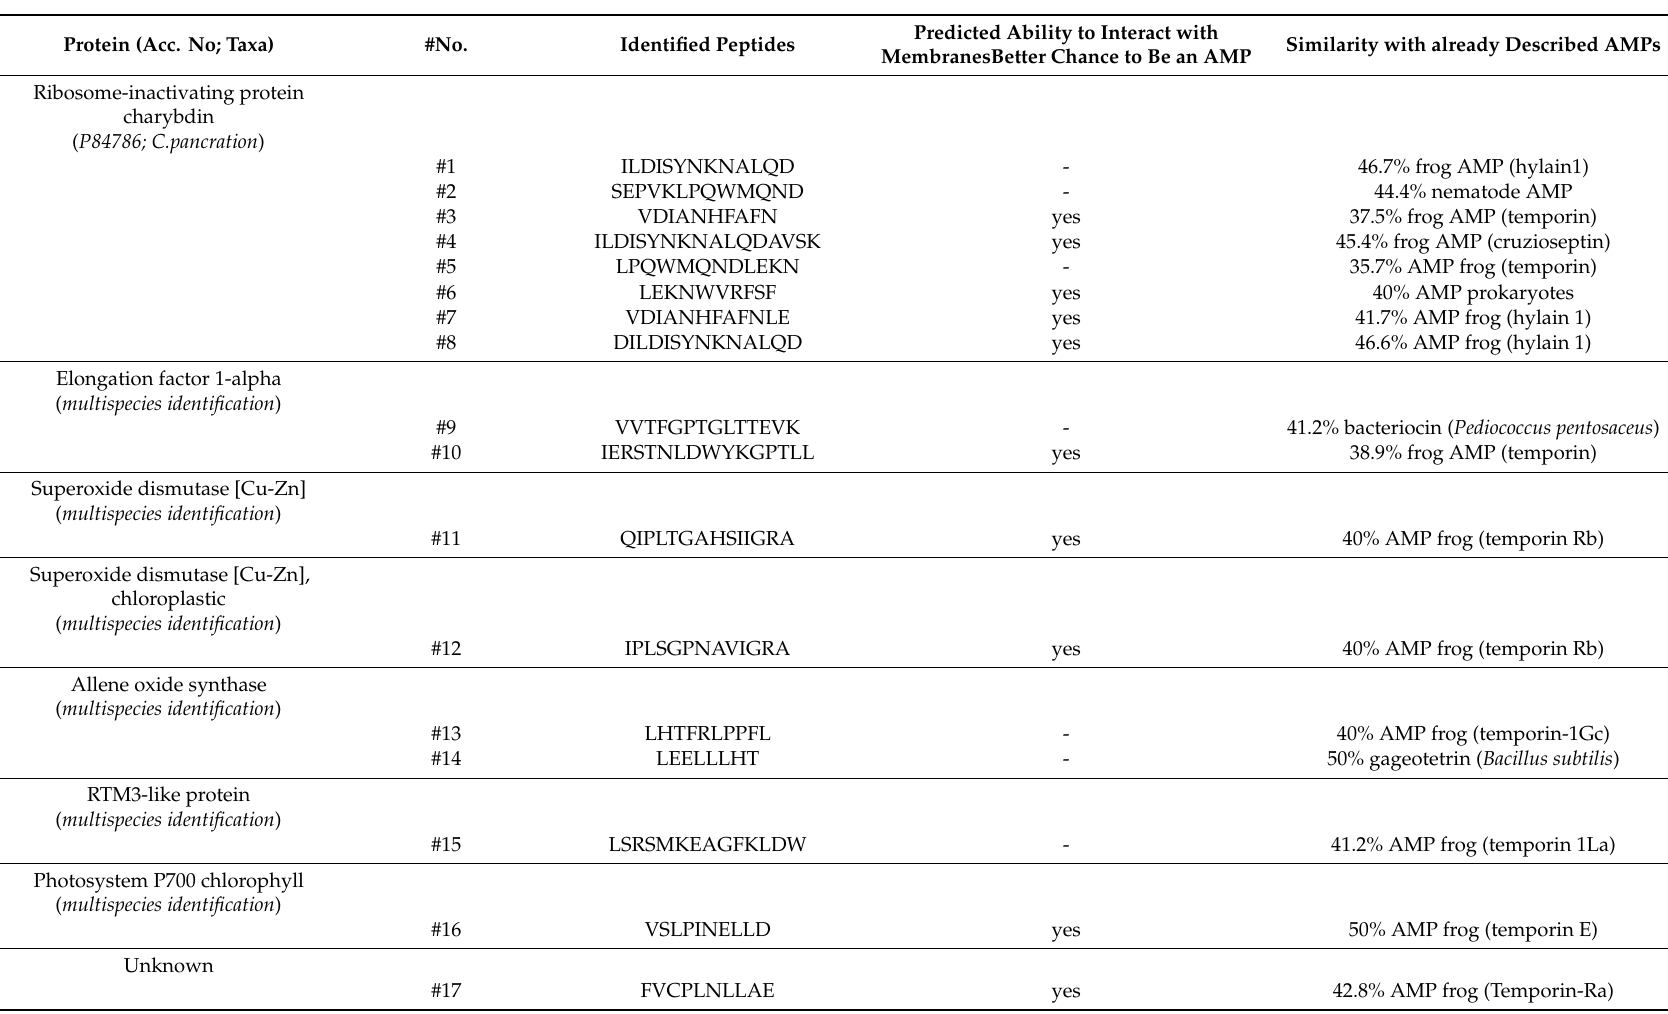
Table 2. Proteins, related peptides and some characteristics as potential AMPs from C. pancration